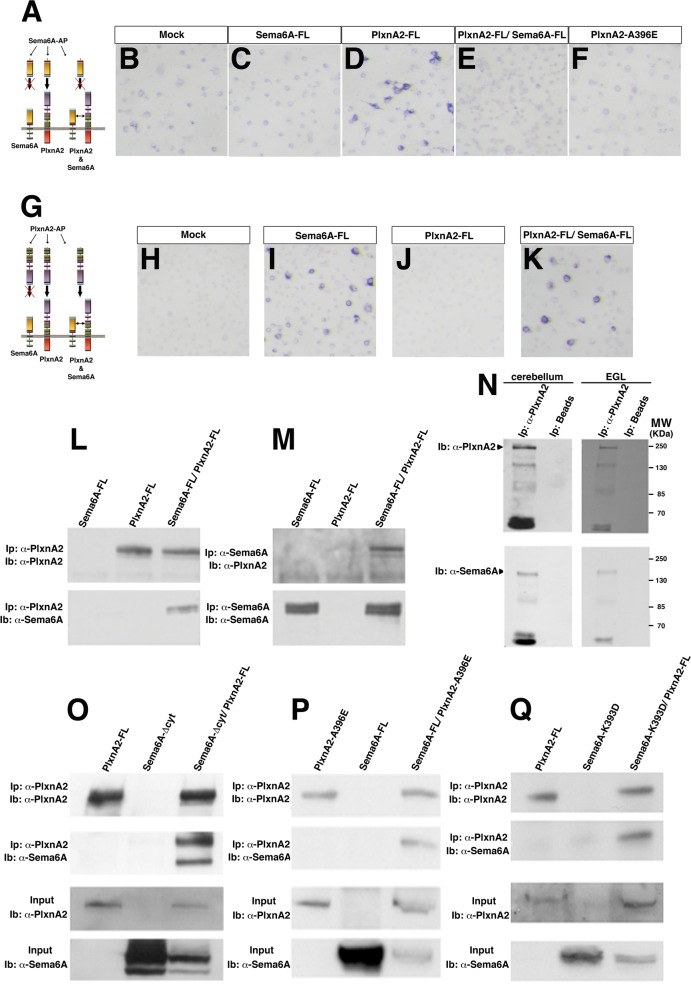
PlxnA2 interacts with Sema6A in cis and in trans.(A) Scheme summarising Sema6A-AP bindings. (B-F): COS-7 cells were transfected with the empty vector (mock; B), Sema6A-FL (C), PlxnA2-FL (D), PlxnA2-FL together with Sema6A-FL (E) or PlxnA2-A396E (F); and treated with Sema6A-AP. (G) Scheme summarising PlxnA2-AP bindings. (H-K): COS-7 cells were transfected with the empty vector (mock; H), Sema6A-FL (I), PlxnA2-FL (J) or PlxnA2-FL together with Sema6A-FL (K) and treated with PlxnA2-AP. (L) PlxnA2 immunoprecipitation (IP) from protein samples of COS-7 cells transfected with Sema6A-FL, PlxnA2-FL or Sema6A-FL together PlxnA2-FL. Antibodies against PlxnA2 and Sema6A were used in the immunoblots. (M) Sema6A IP from protein samples of COS-7 cells transfected with Sema6A-FL, PlxnA2-FL or Sema6A-FL together with PlxnA2-FL. (N) PlxnA2 IP from protein samples of mouse cerebellums or EGL explants. (O) PlxnA2 IP from protein samples of COS-7 cells transfected with PlxnA2-FL, Sema6A-∆cyt or Sema6A-∆cyt together with PlxnA2-FL. (P) PlxnA2 IP from protein samples of COS-7 cells transfected with PlxnA2-A396D, Sema6A-FL or Sema6A-FL together with PlxnA2-A396D. (Q) PlxnA2 IP from protein samples of COS-7 cells transfected with PlxnA2-FL, Sema6A-K393D or Sema6A-K393D together with PlxnA2-FL.